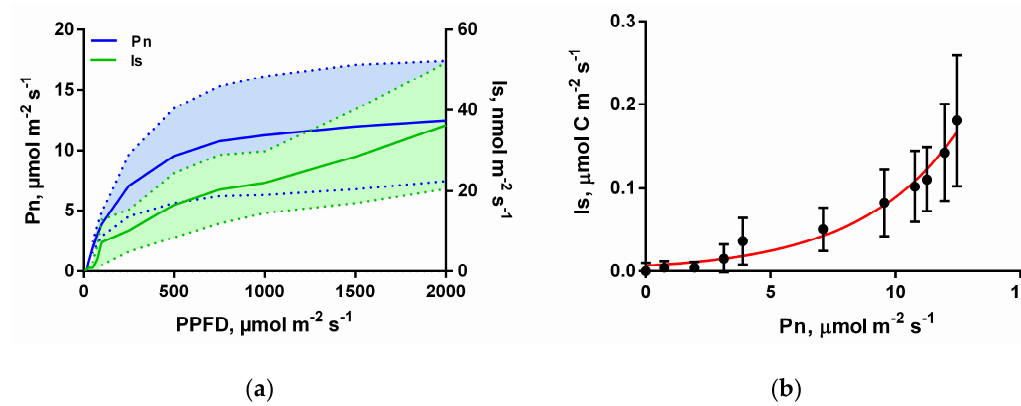
Figure 1. ( a ) Leaf isoprene emissions ( Is , nmol m −2 s −1 ) and net photosynthesis rates ( Pn , µmol m −2 s −1 ) from I. edulis leaves as a function of photosynthetic photon flux density (PPFD) intensity under constant leaf temperature (30 °C) and ambient CO 2 (450 µmol mol −1 ); the solid lines are the averages and the hatching area the standard deviation for n = 7. ( b ) Isoprene emissions expressed in µmol C m −2 s −1 ( IsC ) against Pn (µmol m −2 s −1 ) as PPFD intensity increases in the same conditions; means, and standard deviation for n = 7.